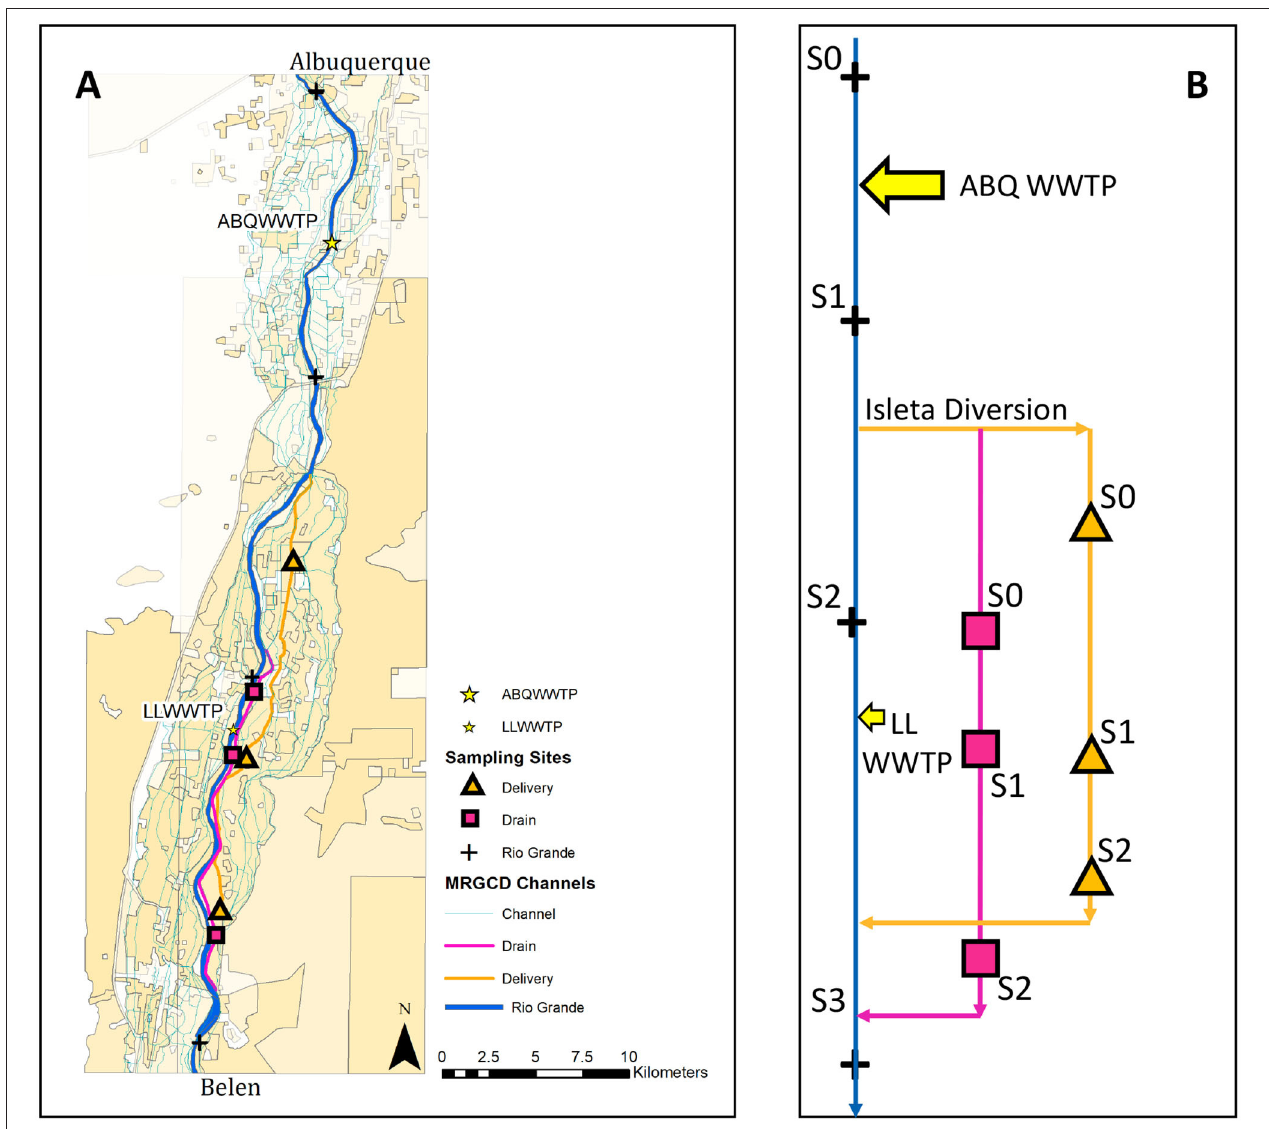
FIGURE 1 | (A) Study reaches: Rio Grande (blue), Drain (pink), and Delivery (orange) channels with sampling sites along each (black markers). The Albuquerque WWTP (ABQ WWTP) and the Los Lunas WWTP (LL WWTP) discharge into the Rio Grande, and are labeled in yellow. (B) Flow schematic using the same color scheme as (A) to show the location of sampling sites in Table 1 in relation to various inputs.